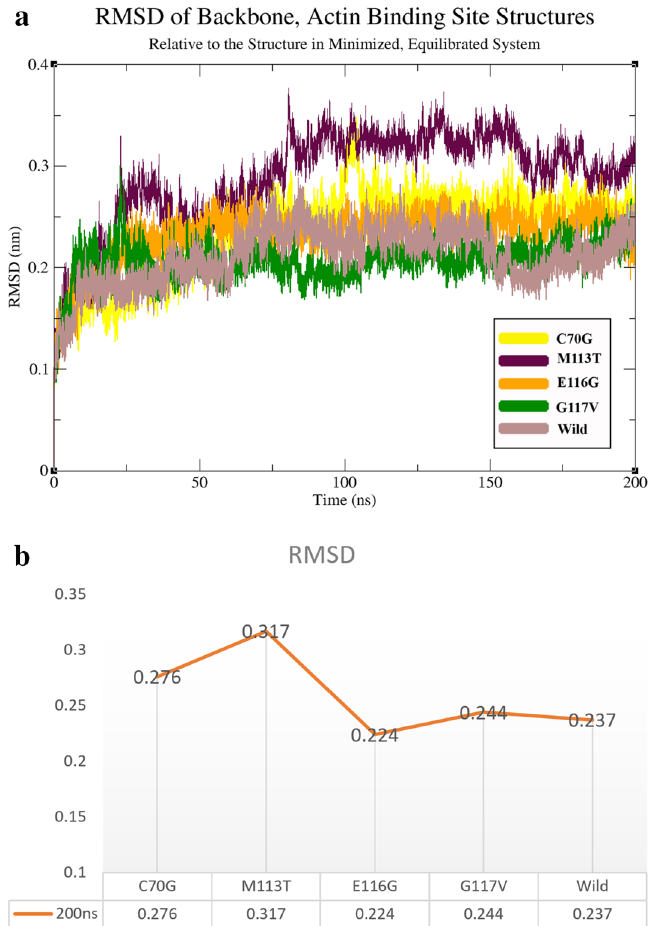
Figure 5. The RMSD data generated from a triplicate runs for 200 ns. ( A ) RMSD of structures after 200 ns relative to the structure in a decent energy-minimized, equilibrated system. ( B ) Compared to RMSD values for 200